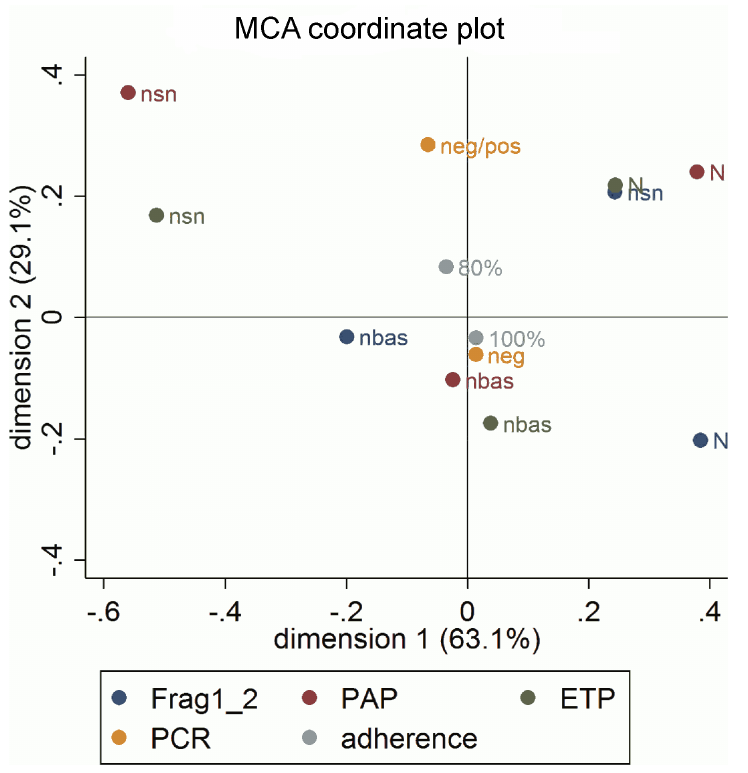
Fig 3. Multiple correspondence analysis coordinate plot. Biomarkers: N, sustained normalization of values throughout follow-up; nsn: non-sustained normalization throughout follow-up; nbas, normal value at baseline. Supplementary variables: qRT-PCR during follow-up: neg (negative); pos (positive); Level of adherence: 80%; 100%. Abbreviations: ETP, endogenous thrombin potential; F1+2, prothrombin fragment 1+2; PCR, polymerase chain